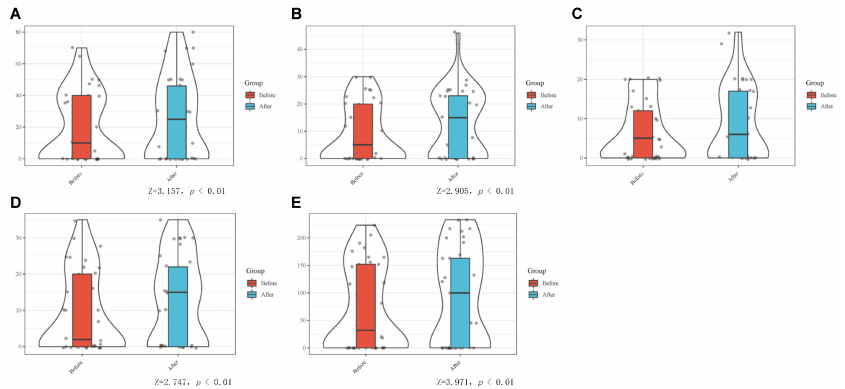
Figure 9. Comparison the differences of the AROM in finger adduction and abduction. With pro- tractor before and after rehabilitation treatment. ( A ) Finger adduction and abduction 1; ( B ) Finger adduction and abduction 2; ( C ) Finger adduction and abduction 3; ( D ) Finger adduction and abduc- tion 4; ( E ) Sum of finger adduction and abduction. Z represents the effect size of the two-sample K-S test (see Methods).